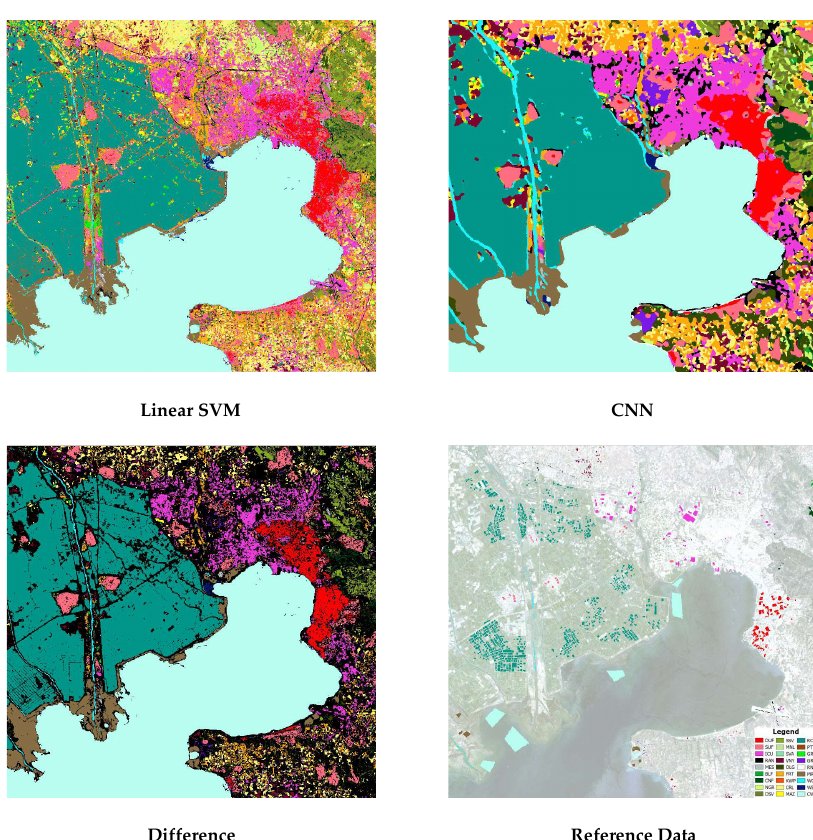
Figure 5. Part of the resulting linear SVM ( top left ) and CNN ( top right ) land cover maps for Dataset #1. Bottom : their difference (black) and the reference data for this particular region (approx. 2000 km 2 ) are